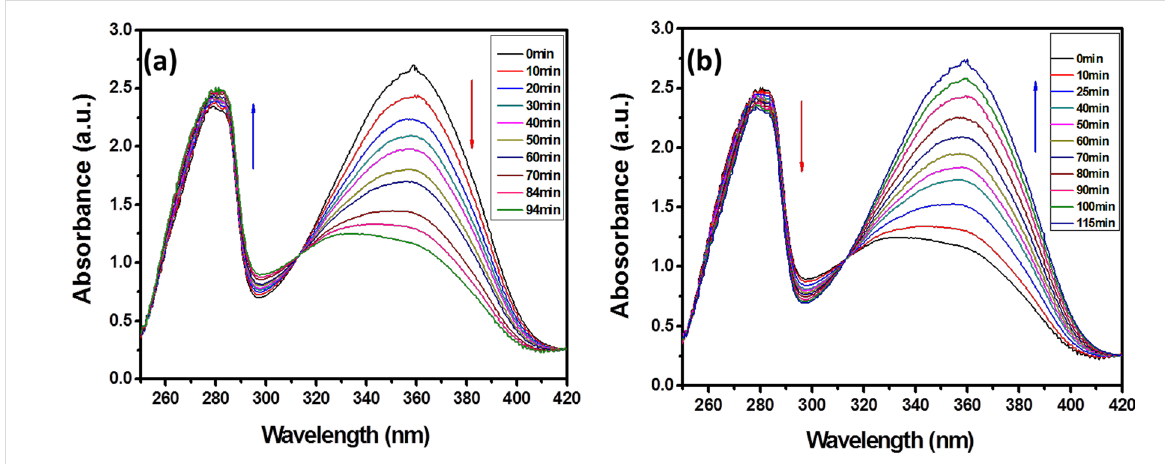
Figure 1: Changes in the absorption over time in the UV–vis spectra of dilute THF solution of M 0 : (a) upon UV-light irradiation ( λ = 365 nm) and (b) upon visible-light irradiation ( λ = 450 nm) of the solution obtained after irradiation of 365 nm.